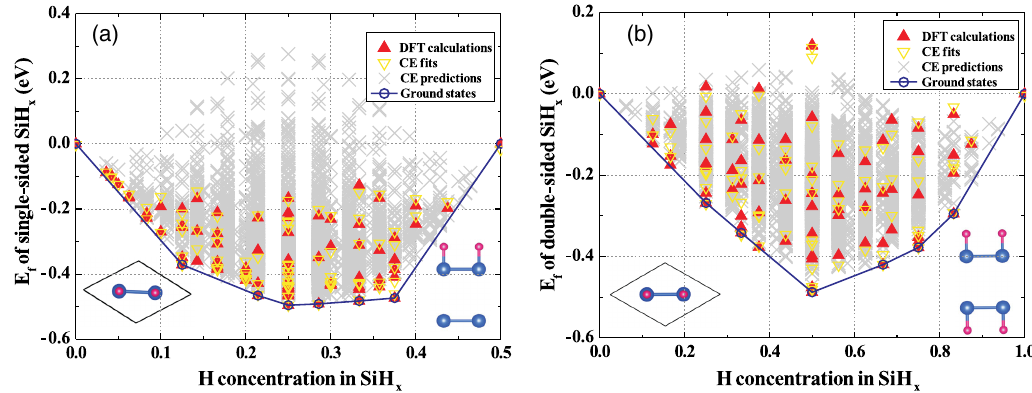
FIG. 2. (a) The calculated formation energies E of all the symmetry-inequivalent structures calculated from CE are also plotted here. Inset: The top and side views of the structures of SiH 0 . Panel (b) is the same as (a) but for double-sided SiH . 5